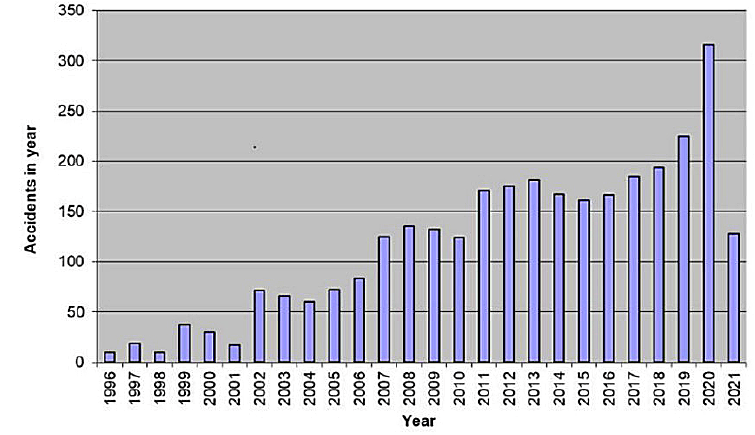
Figure 1. Statistics of wind turbine accidents recorded since 1996 [8].